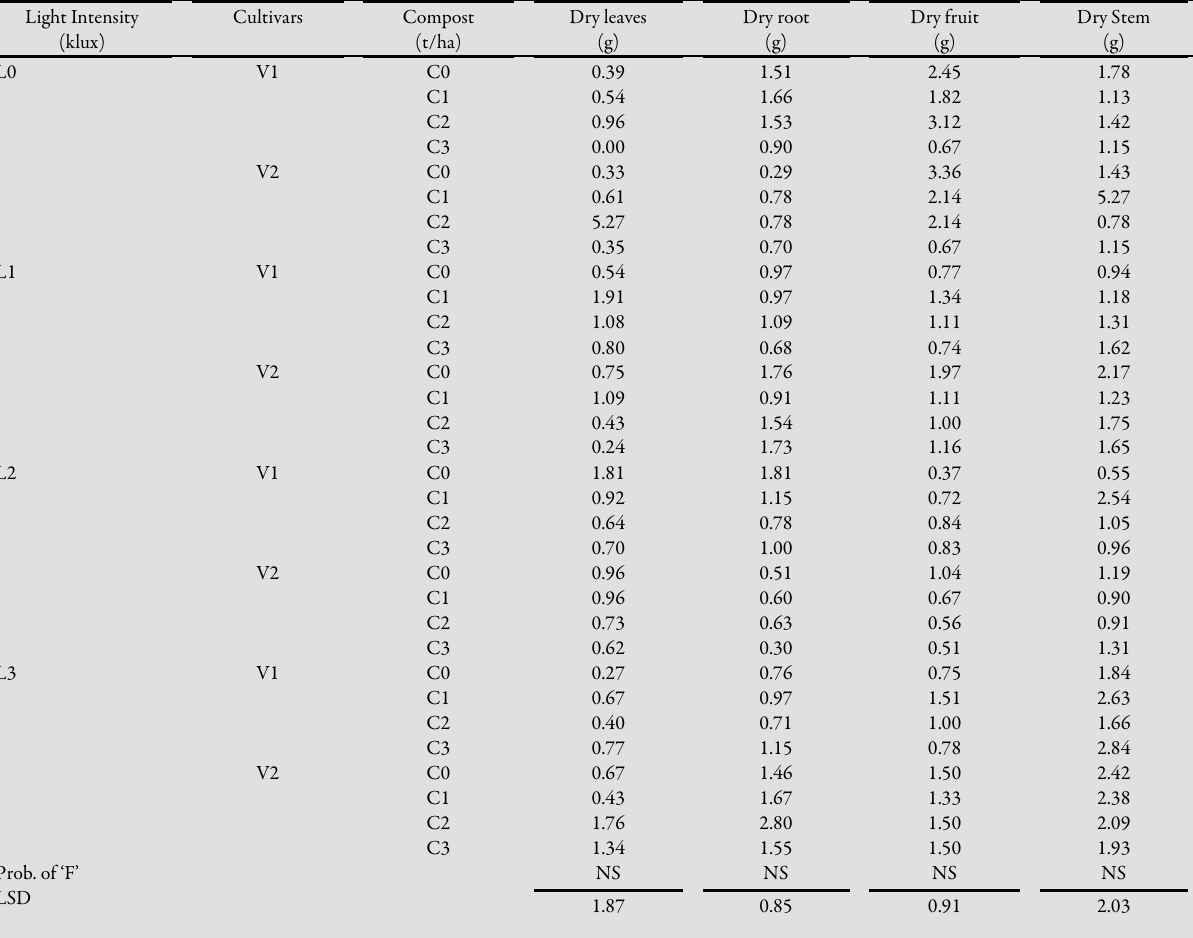
Table 6. Interactive effects of compost and light intensity on the dry matter accumulation of two cultivars of okra in the pot experiment Light